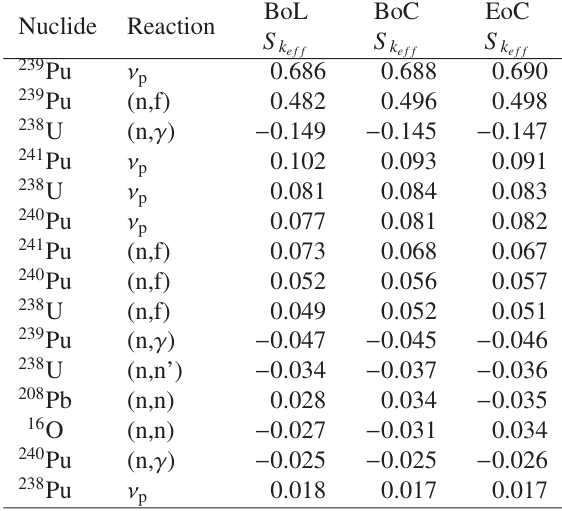
Table 1. Top 15 Integrated Sensitivity Coe ffi cients for ALFRED and di ff erent reactor cycles. The statistical uncertainty of the sensitivity coe ffi cients due to Monte Carlo calculations is 10 -5